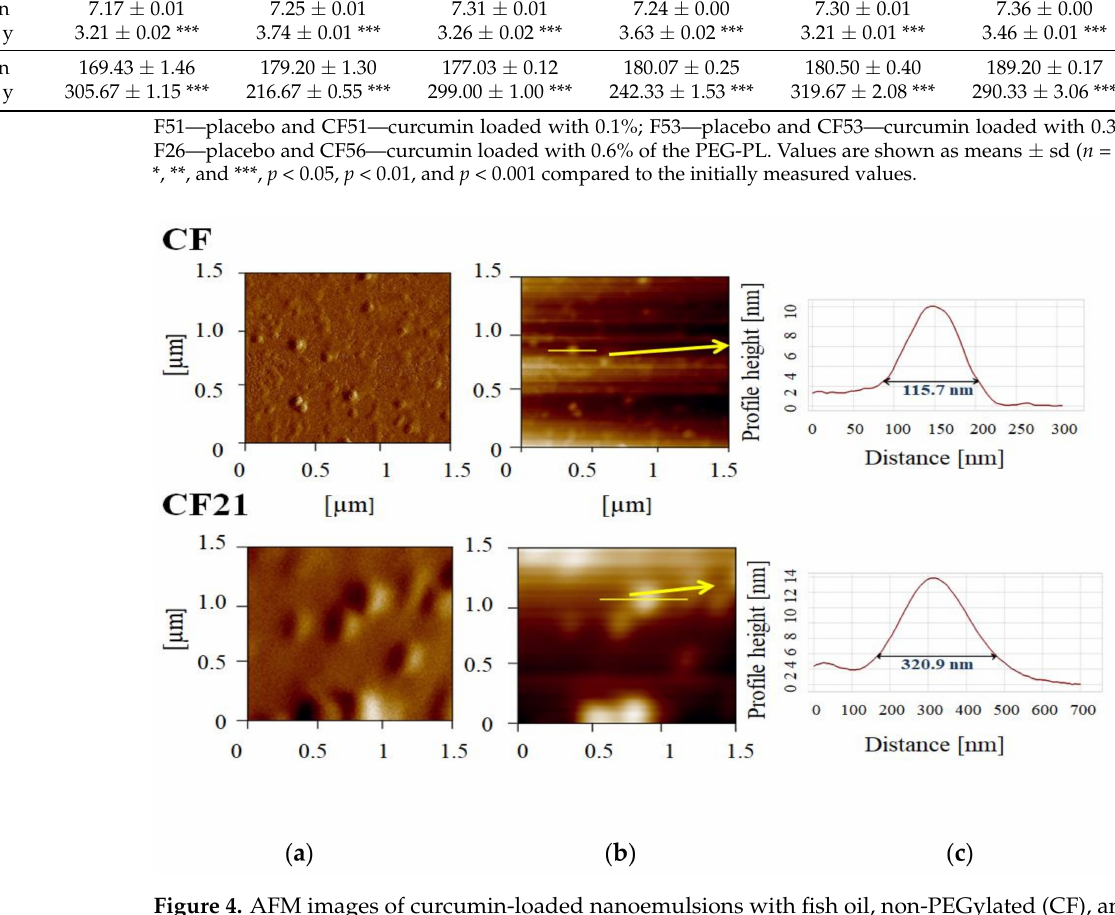
Figure 4. AFM images of curcumin-loaded nanoemulsions with fish oil, non-PEGylated (CF), and PEGylated containing 0.1% of PEG2000-DSPE (CF21): ( a ) error signal of 1.5 × 1.5 µ m 2 area of the sample; ( b ) 2D topography; ( c ) height profiles of selected nanoemulsion